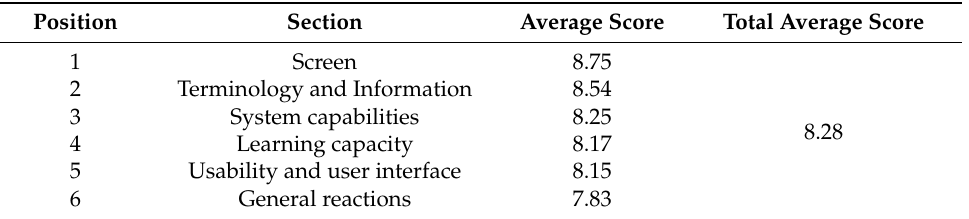
Table 5. Results of Instrument 2, physician profile.